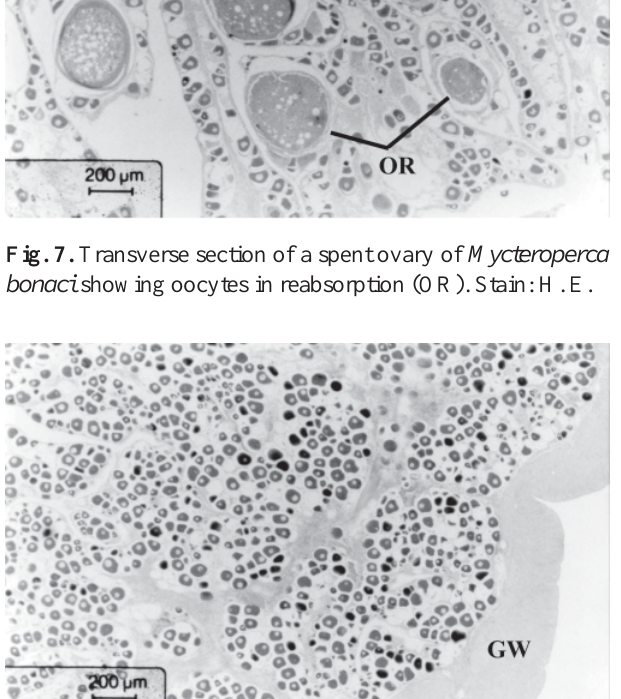
Fig. 10. Transverse section of the gonad of Mycteroperca bonaci showing oocytes with eroded nucleus and cytoplasm fragmented in transitional individual. Fragmented oocytes (FO).